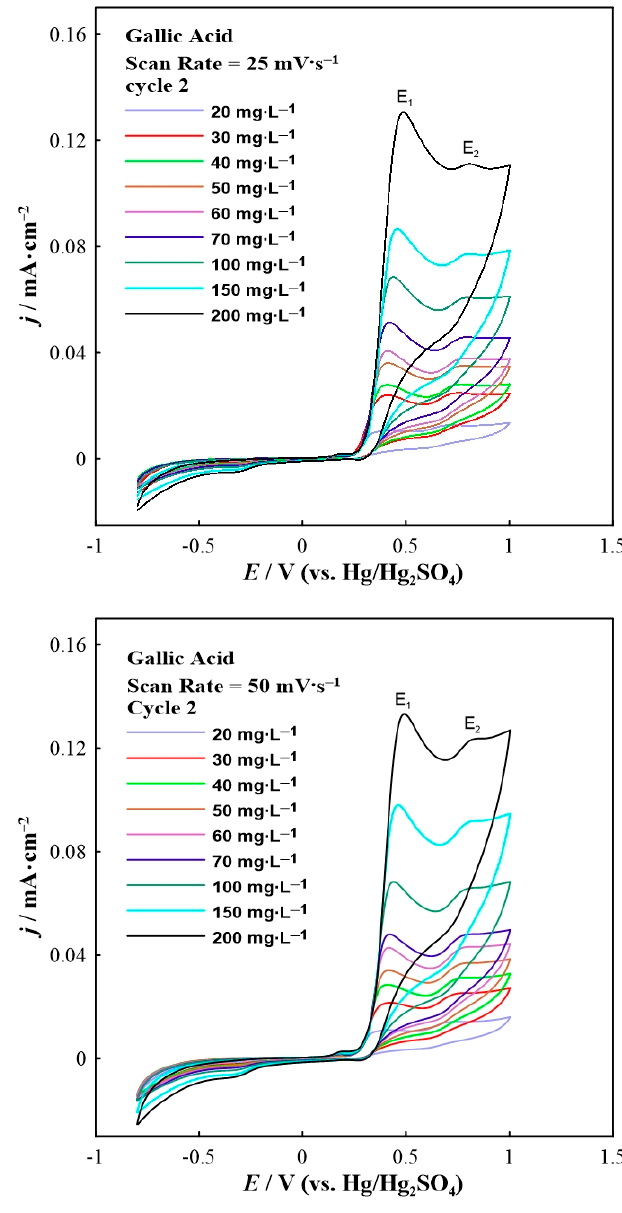
Figure 1. Second scan of the cyclic voltammograms for gallic acid in various concentrations at a constant scan rate of 25 ( top ) and 50 ( bottom ) mV · s − 1 .